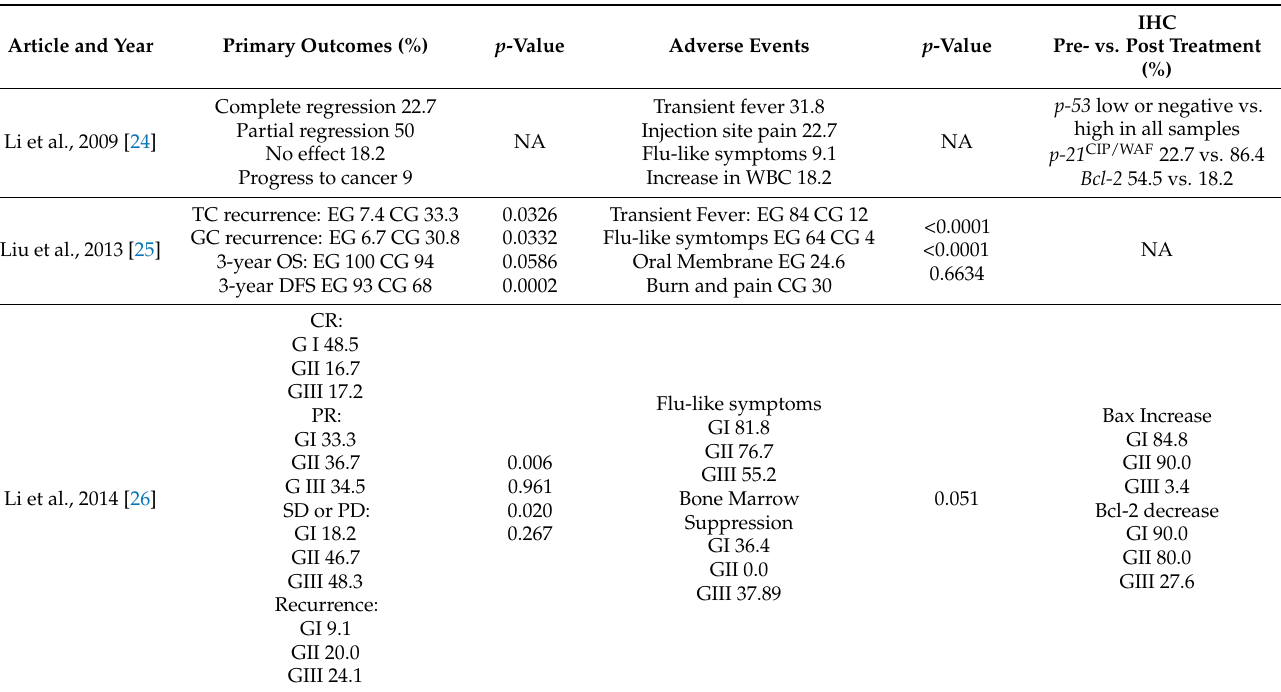
Table 3. Summary of results from the three